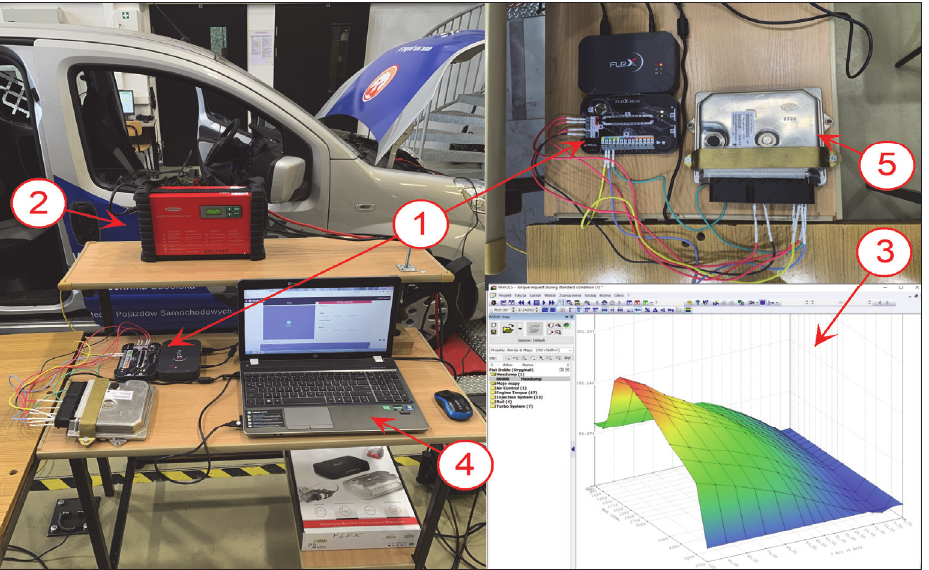
Figure 3. Read-write-programming apparatus consisting of 1. FLEX MASTER from Magic Motorsport, 2. Fronius Acctiva Professional Flash 70A power supply, 3. WinOLS Version 4.51 software, 4. Mobile computer with Flex and WinOLS software installed. 5. a copy of the ECU controller from the Fiat Qubo.